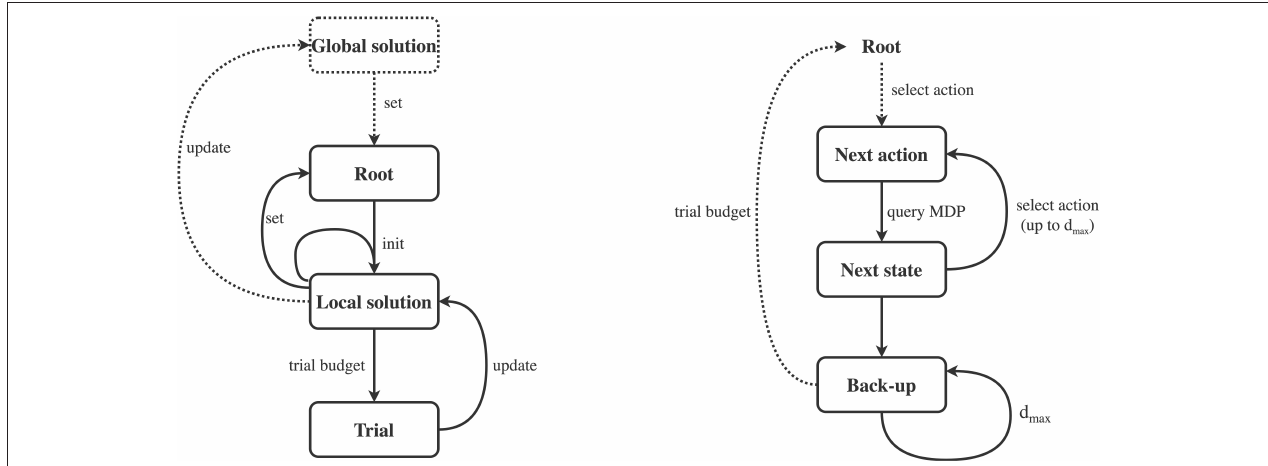
FIGURE 2 | Graphical illustration of framework (Algorithm 1). Left: Algorithm outer loop (Algorithm 1, line 4), illustrating the interplay of global and local solutions with trials. After possibly initializing a global solution, we repeatedly fix a new root state for which we want to improve our solution. Then, we initialize a new local solution for the particular root, and make one or multiple trials (trial budget), where each trial updates the local solution. After the budget is expanded, we may use the local solution to update the global solution and/or set the next root state and/or reuse information for the next local solution. The process then repeats with setting a new root, possible based on the global and/or local solution. Right: Algorithm inner loop (Algorithm 1, line 5), illustrating an individual trial. A trial starts from a root node, from which we repeatedly select actions, query the MDP at the specific state-action pair, and then transition to a next state. We repeat this process d max times, after which we start the back-up phase, consisting of d max back-ups. When budget is available, we start another trial from the same root node.